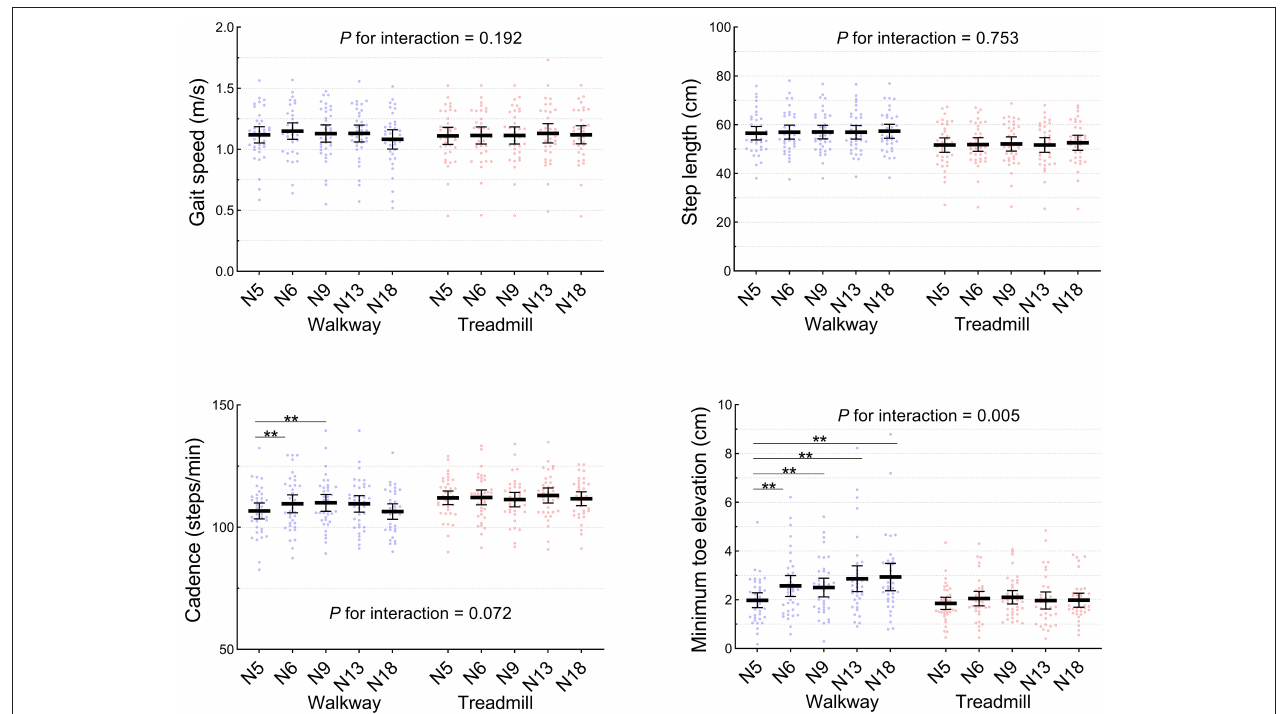
FIGURE 2 | Spatiotemporal parameters during normal walks on the treadmill and overground walkway ( n = 38). N5 and N6 were prior to and following the first trip, respectively. The middle and error bars represent mean and 95% confidence interval. ** P < 0.01.